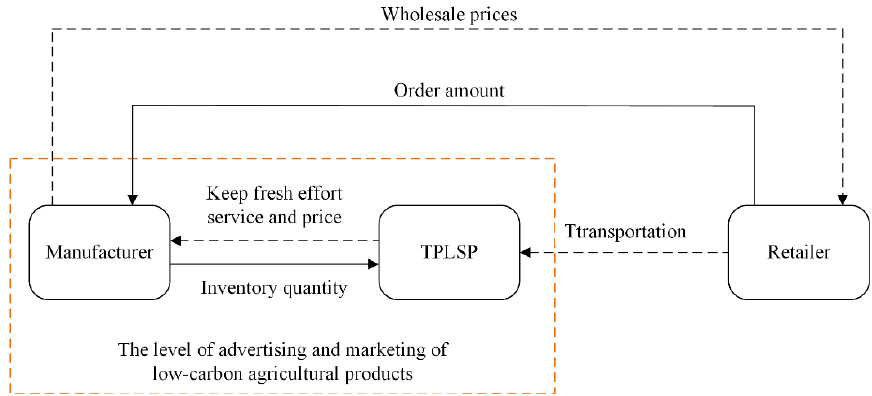
Figure 2. Timeline of events in the proposed model.